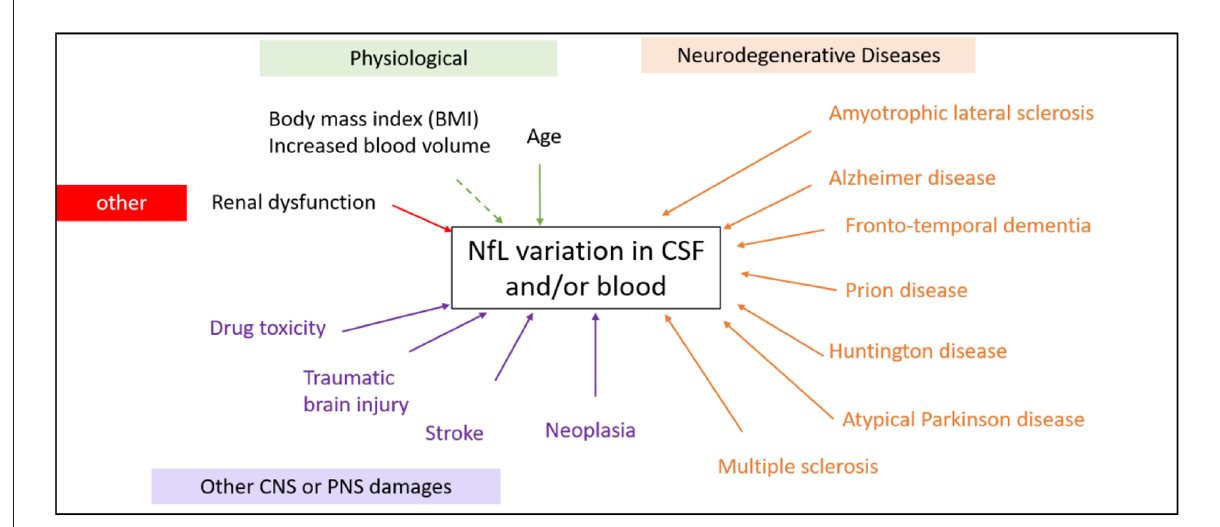
FIGURE4 Physiological and pathological factors modifying the NfL levels in CSF and blood (non-exhaustive). A rise in NfL is not specific for a specific disease factor and may be caused by both neurodegenerative diseases or a head impact during sports for